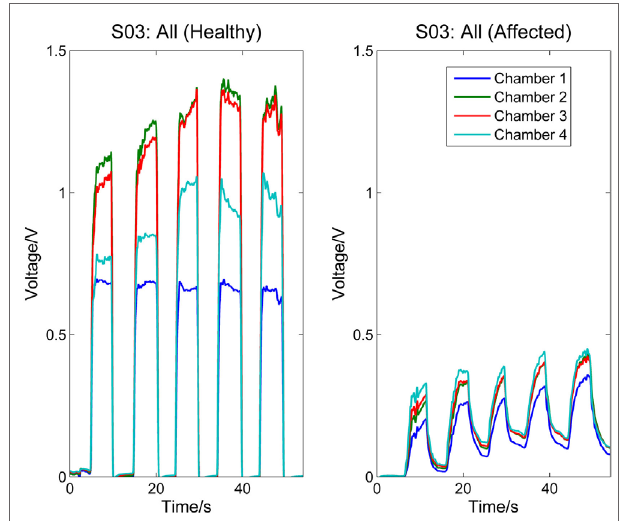
FigUre 5 | comparison between healthy and affected hands of s03 (grasp) . Signals recorded from the four chambers of the finger sensor when S03 compressed it with all fingers (both healthy and affected).